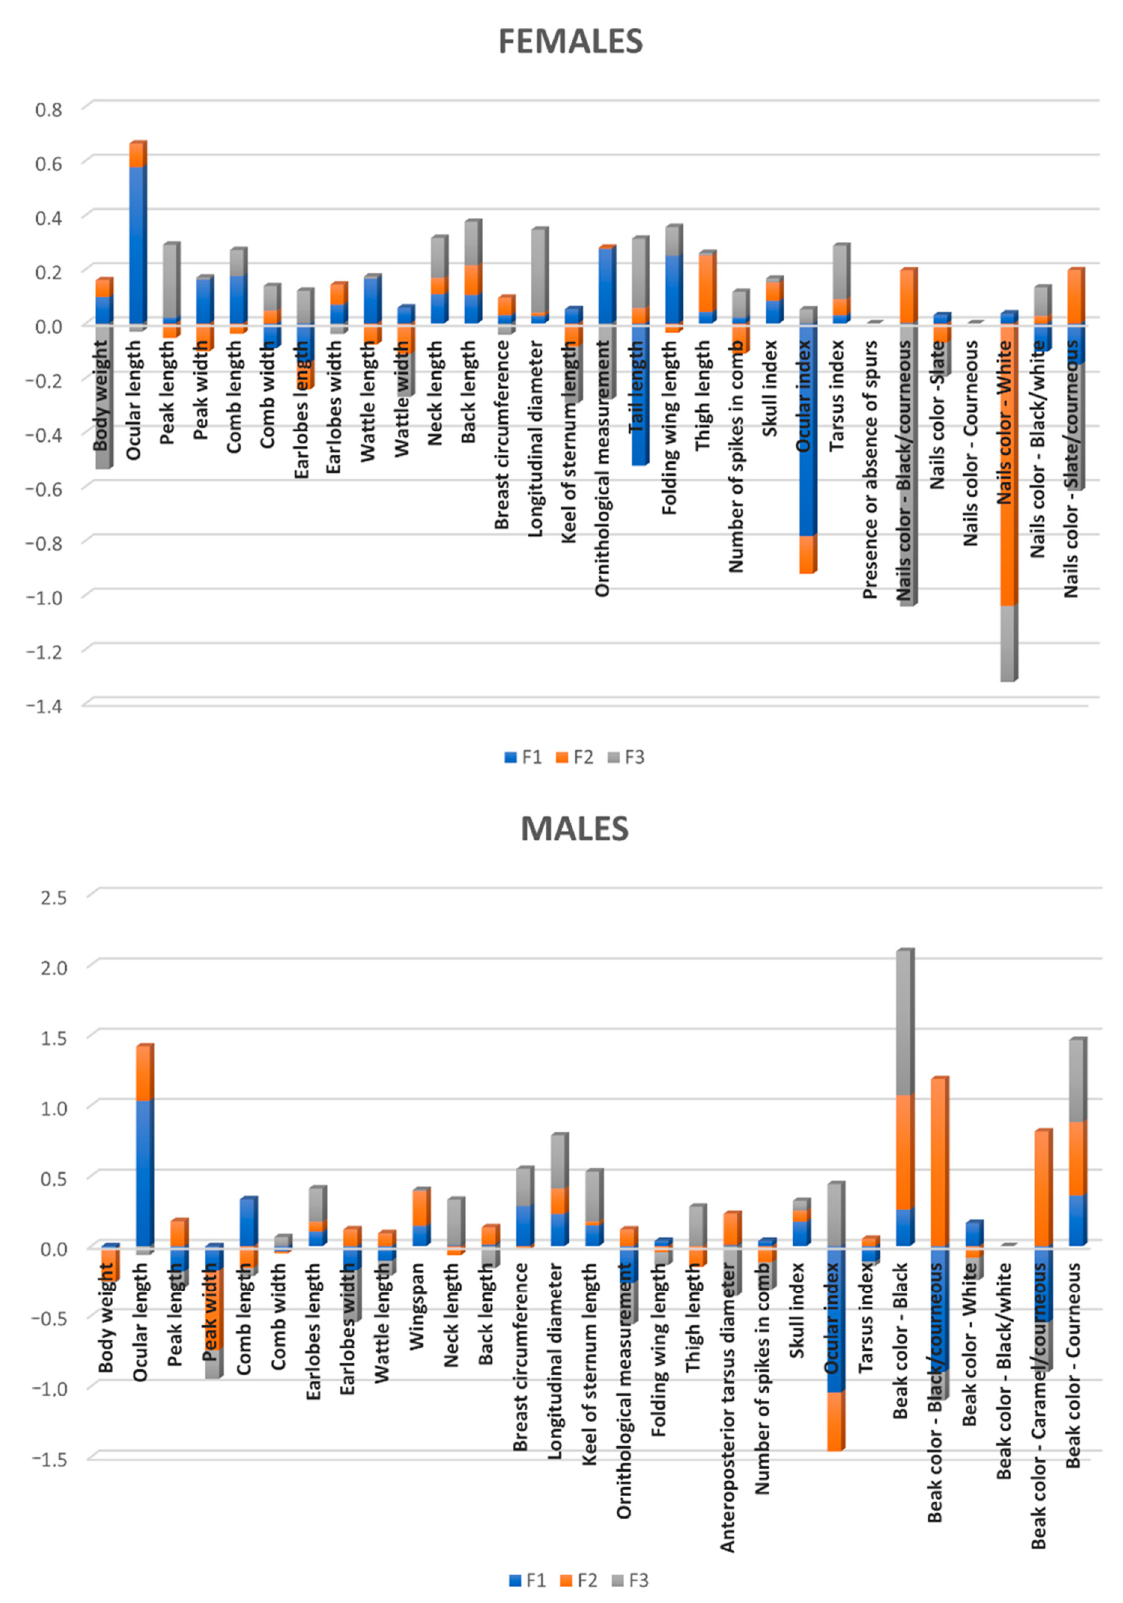
Figure 3. Discriminant loadings for biometric quality-related traits determining the relative weight of each trait on each canonical discriminant function. Each bar represents the relative weights (coefficients) of each variable across the three discriminant functions revealed by CDA.